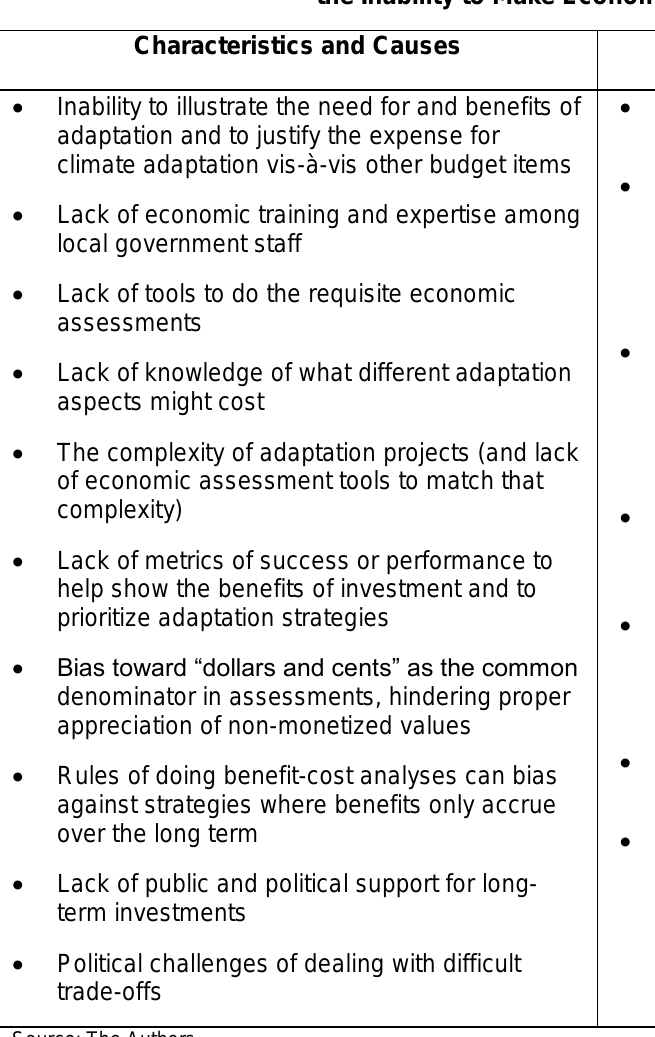
Table A2.7: Characteristics, Underlying Causes and Potential Solutions to